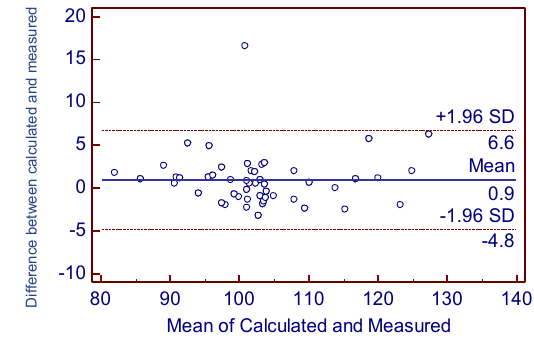
Blad-Altman plot showing agreement between calculated and measured serum chloride